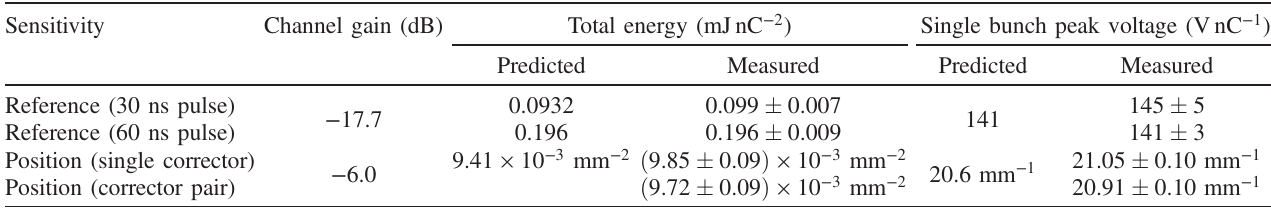
TABLE VII. Results of measurements of the reference cavity sensitivity to bunch charge and the position cavity to a change in horizontal beam position with the corresponding single bunch sensitivities calculated using Eq.